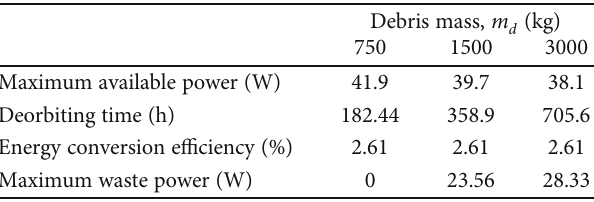
Table 4: Battery performance for di ff erent debris